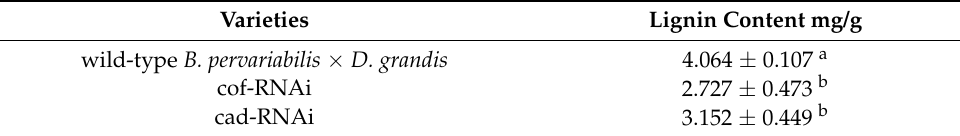
Table 2. Lignin content in transgenic plants.